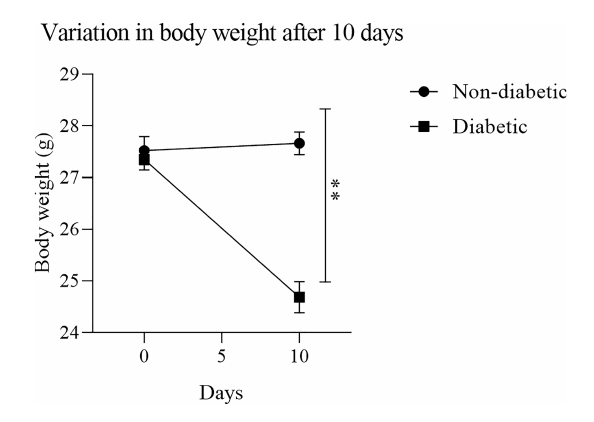
FIGURE 1 Variation in body mass after diabetes induction: After treatment with the diabetogenic agent Alloxan (60mg/kg), it was observed that the induced animals had a signi fi cant weight loss. Results expressed in Sidak Simultaneous Comparison Test **p<0.005,